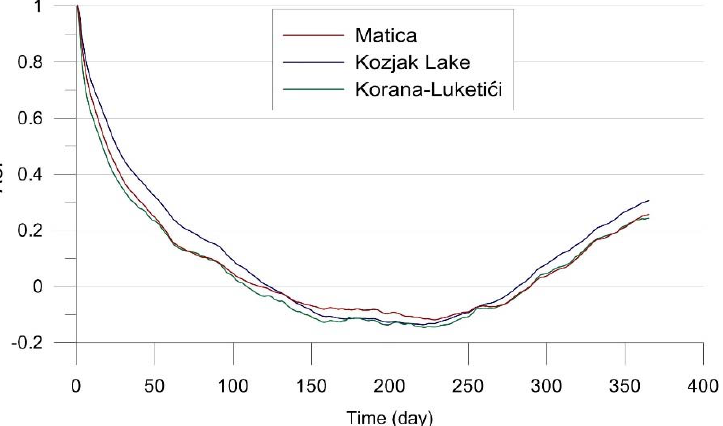
Figure 7. Autocorrelation functions (ACF) of the mean daily discharges at Kozjak Lake, Matica, and Korana ‐ Luketi ć i (1978–2020).